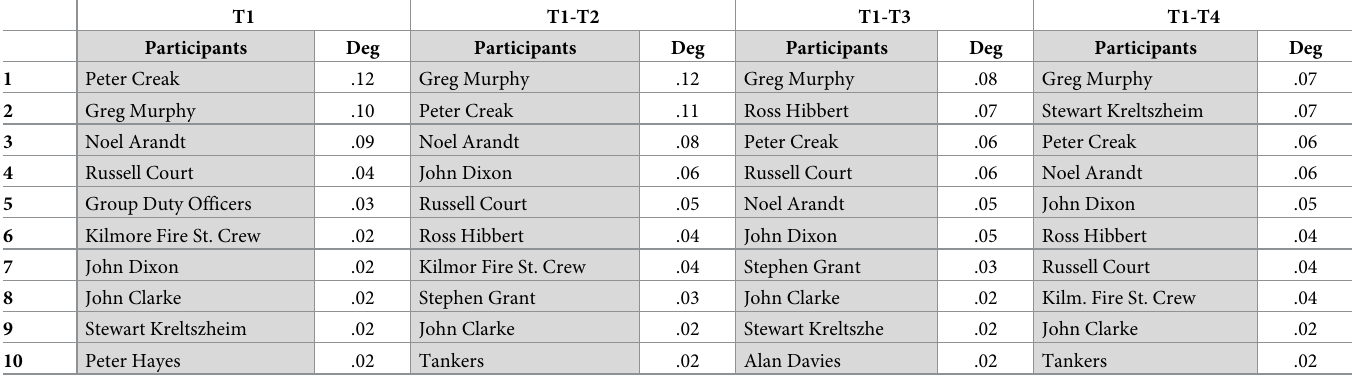
Table 4. Top 10 active participants (normalized weighted degree centrality).